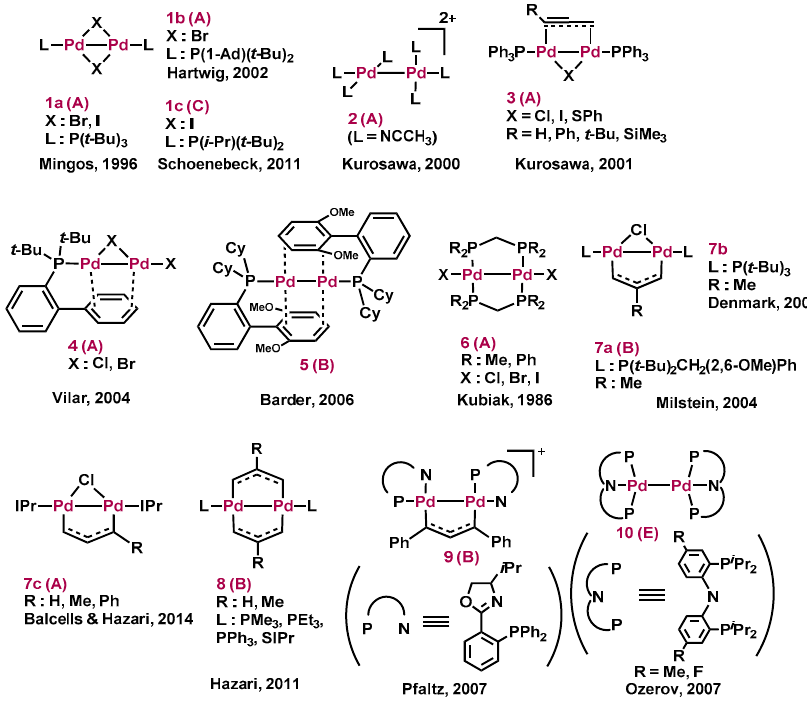
Figure 1. Representative examples of dinuclear Pd complexes. In parenthesis, the synthetic methods A–E are shown.